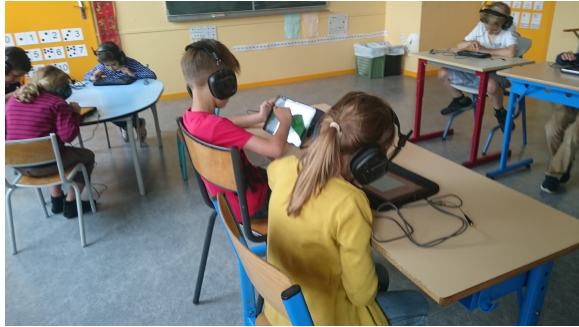
Figure 12. Experiments in class: a group of children manipulating serious games